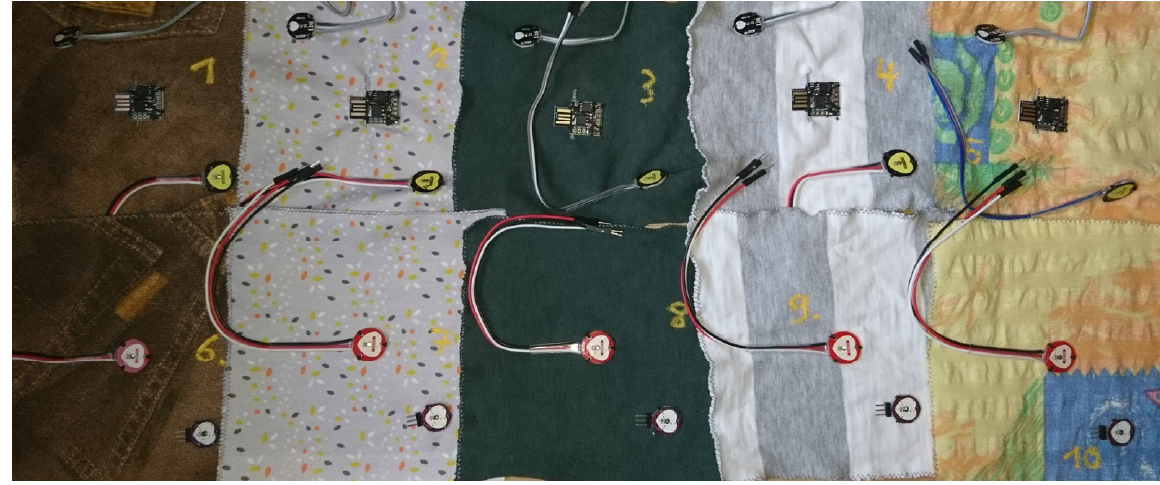
Figure 2. Samples for washing tests.